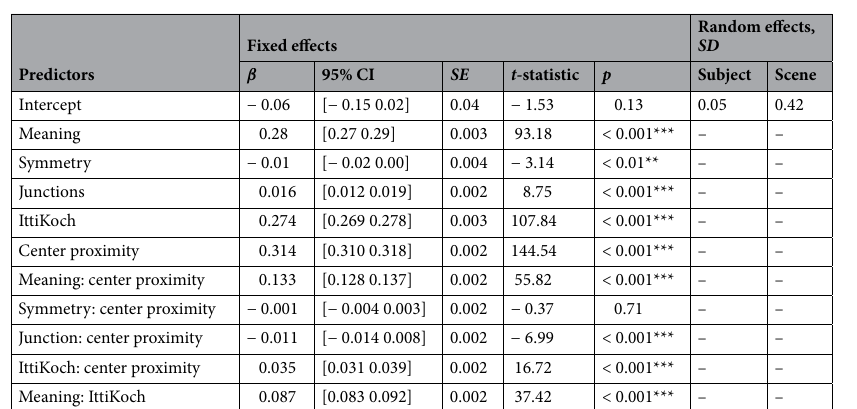
Table 4. SAM-ResNet LME results. Beta estimates ( β ), 95% confidence intervals (CI), standard errors (SE), t values, and p values ( p ) for each fixed effect and standard deviations ( SD ) for the random effects of subject and